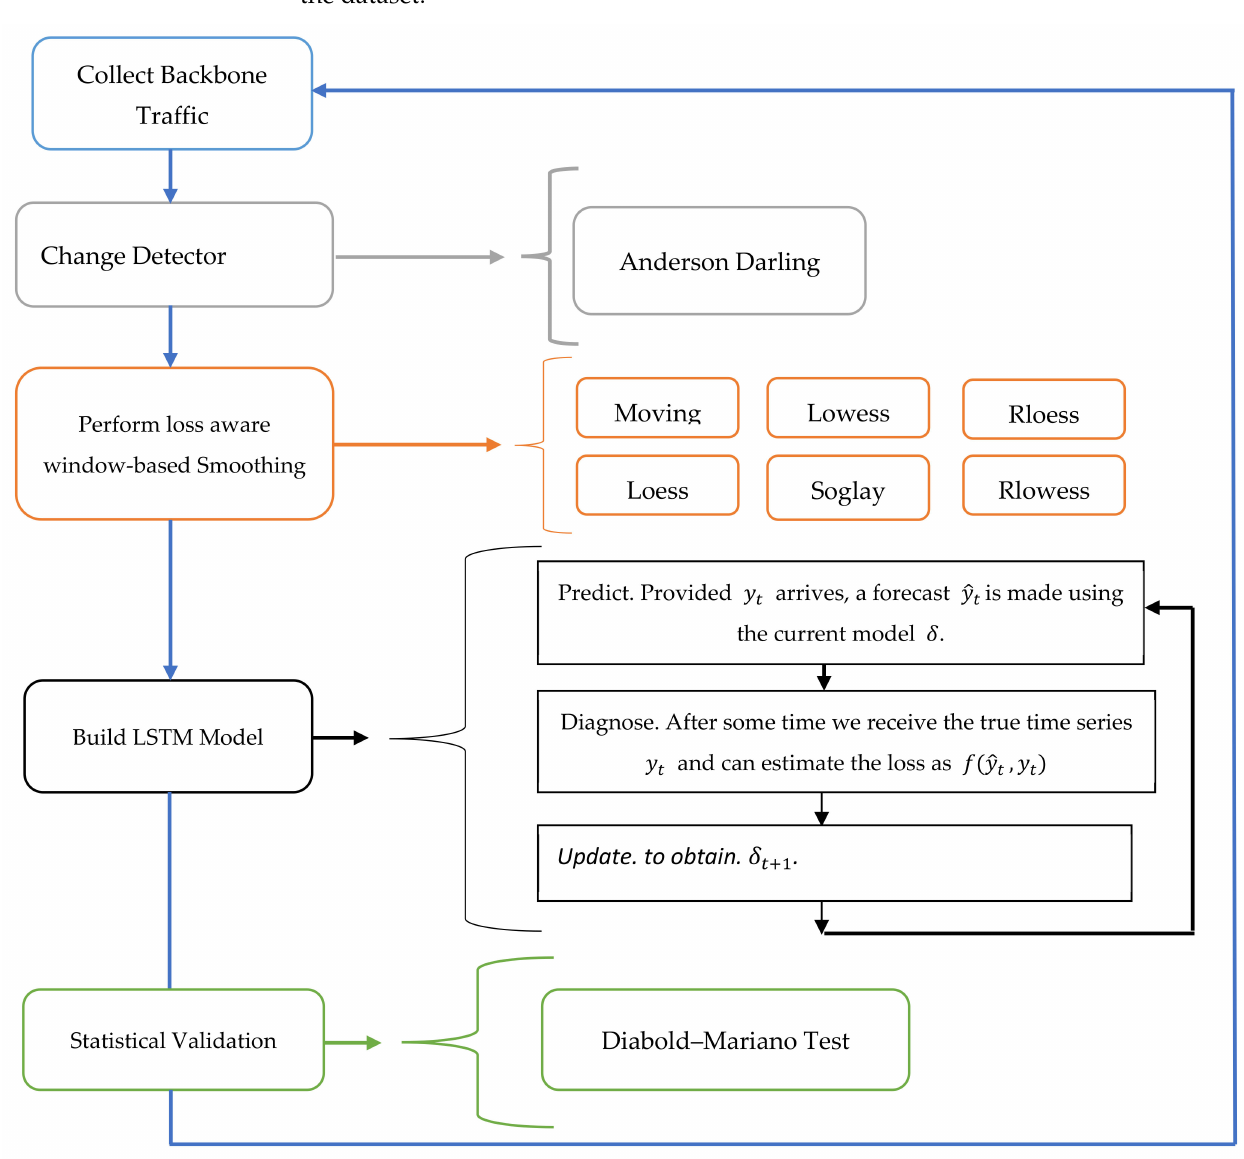
Figure 1. Conceptual